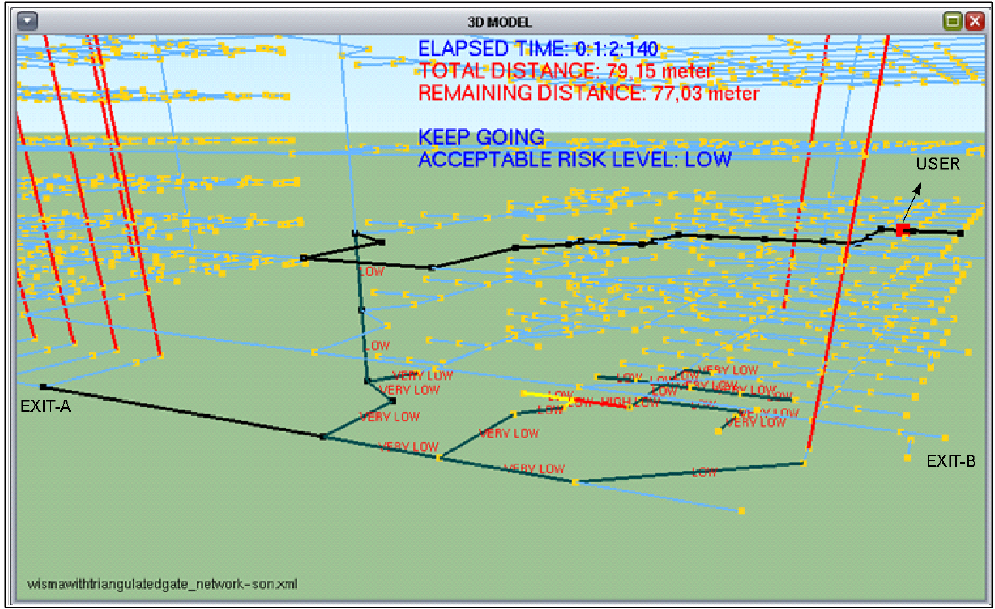
Figure 8. Risk levels predicted for Evacuee-1.